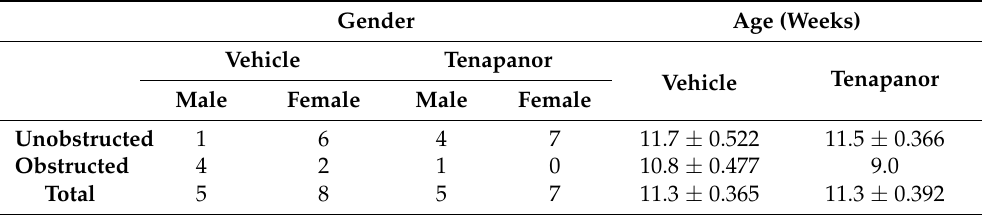
Table 1. Gender and age of the mice that developed obstruction and those that did not at the start of the experimental